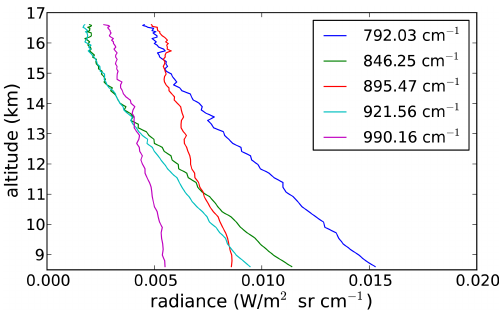
Figure 6. GLORIA integrated radiances for some spectral windows as selected by the genetic algorithm. The data is for Image 72 at 67 ◦ N and 7 ◦ E on 16 December, 15:05UTC.